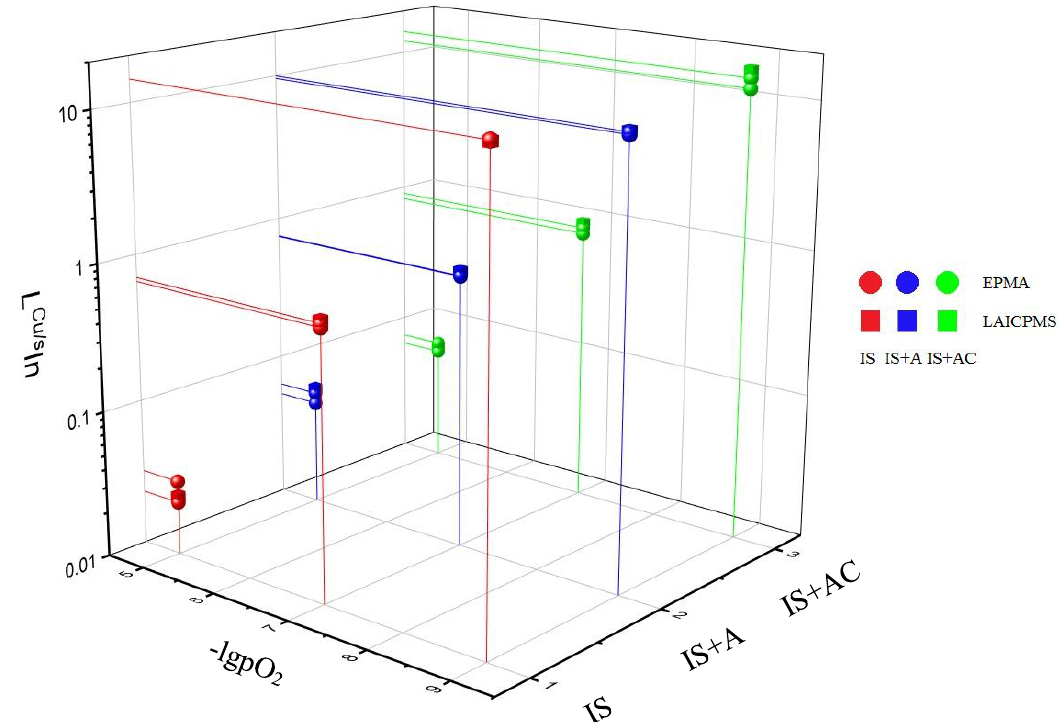
Figure 3. Distribution coefficient of indium as a function of pO 2 and slag composition at 1300 °C. Red symbols indicate pure iron–silicate slag (IS), blue represents iron–silicate slag including 10 wt% alumina (IS + A) and green symbols refer to iron–silicate slag with 10 wt% alumina and 5 wt% lime (IS + AC). Moreover, round symbols indicate to distribution coe ffi cients calculated from the EPMA results of indium in slags and cube symbols to LA-ICP-MS results of indium in